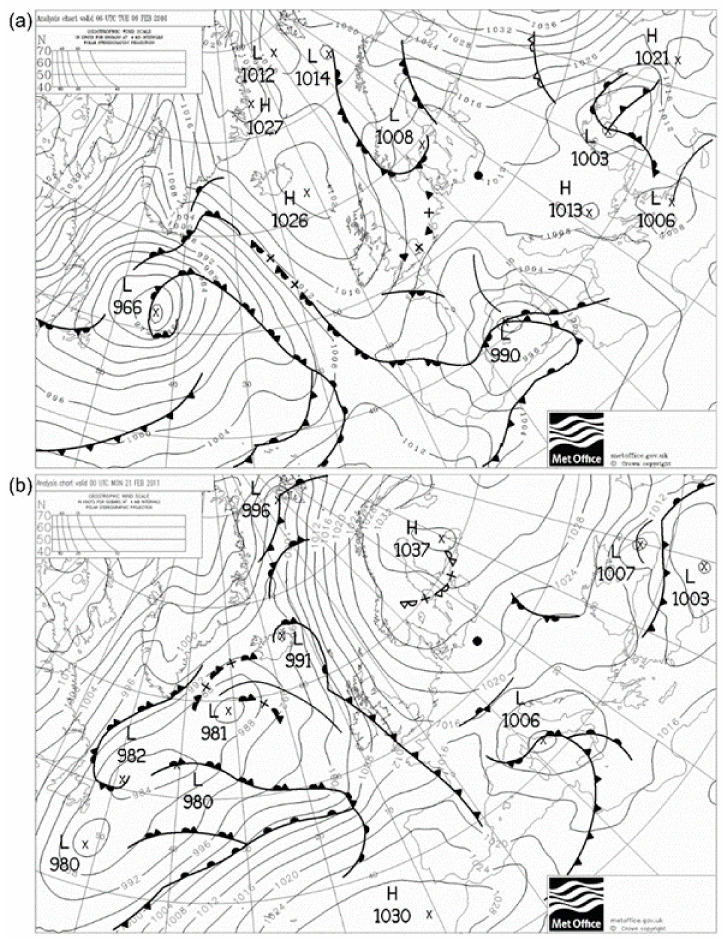
Figure 9. Synoptic maps on 9 February 2010 ( a ) and 21 February 2011 ( b ). Source: Met